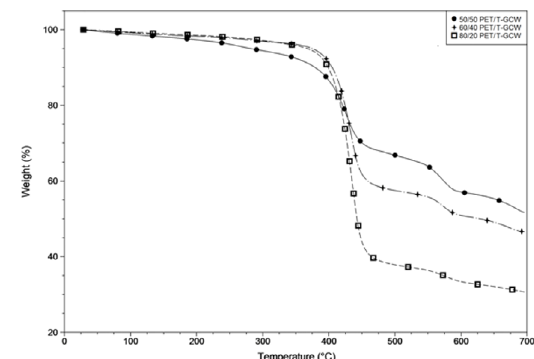
Figure 7. Overlay of the TG curves of PET/U-GCW composites.